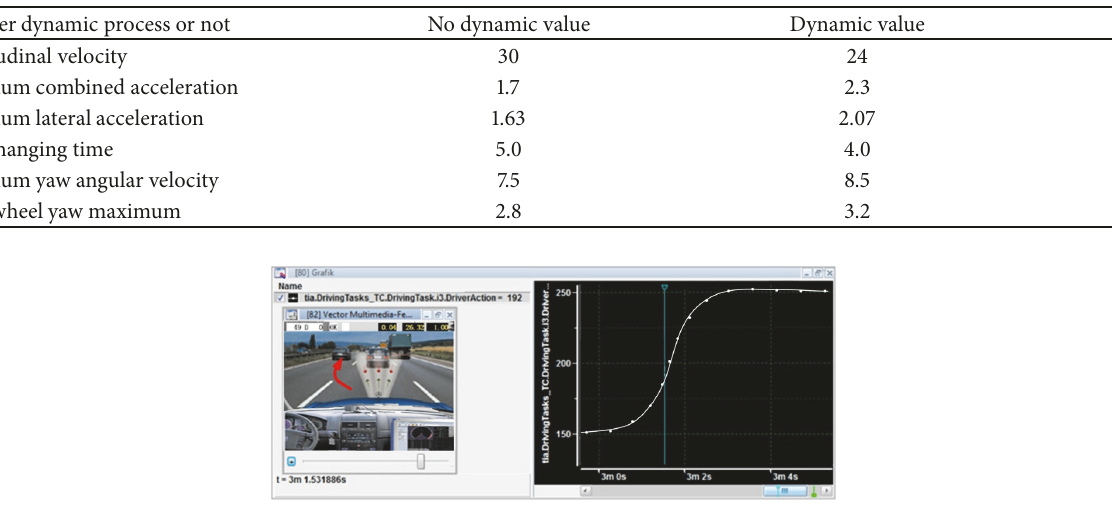
Figure 11: Data acquisition in collision avoidance experiment.